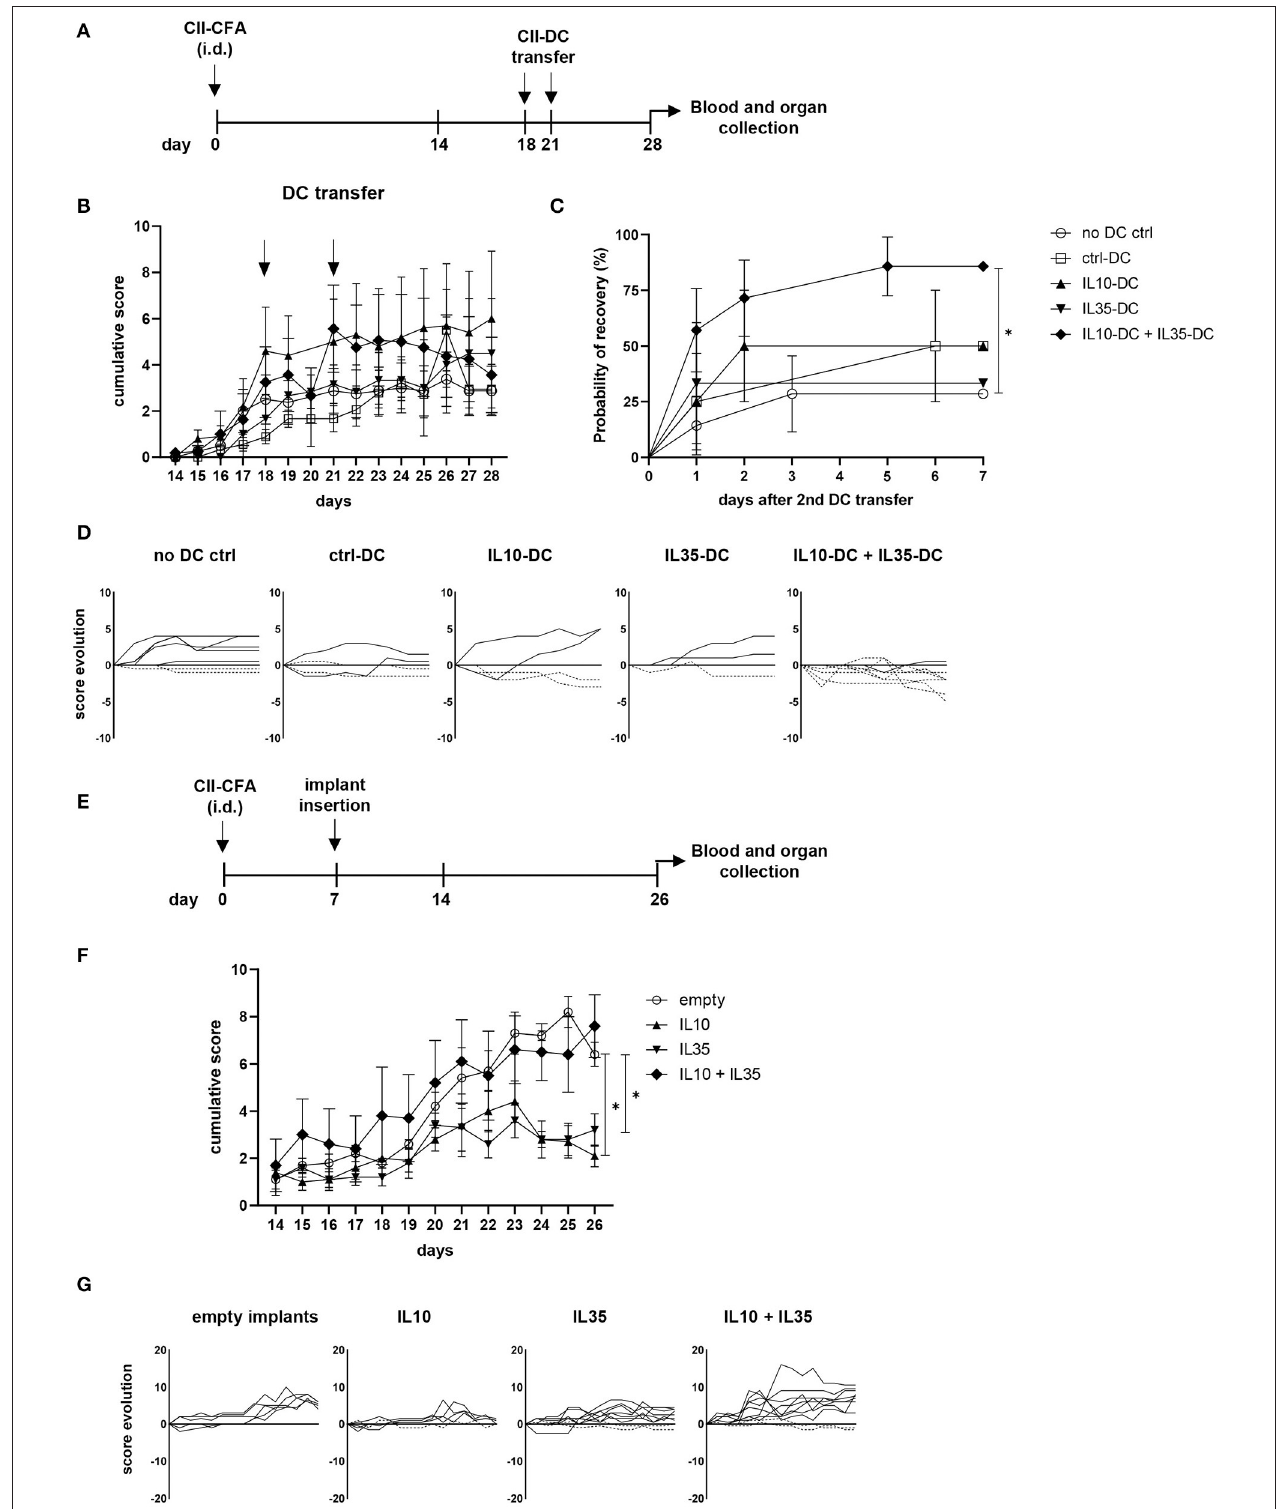
FIGURE 4 | IL10-DC + IL35-DC vaccination reduced established CIA clinical scores. CIA was induced with an i.d. injection at the base of the tail of 100 µ g of chicken collagen II emulsified in Complete Freund’s Adjuvant (5 mg/mL) (CII-CFA). At day 18, when 80% of mice were showing at least mild scores of the disease, mice were vaccinated with 5 × 10 6 CII-pulsed DCs (CII-DC). Treatment was repeated 2 days later. Arthritis severity was evaluated daily and each paw was individually scored for